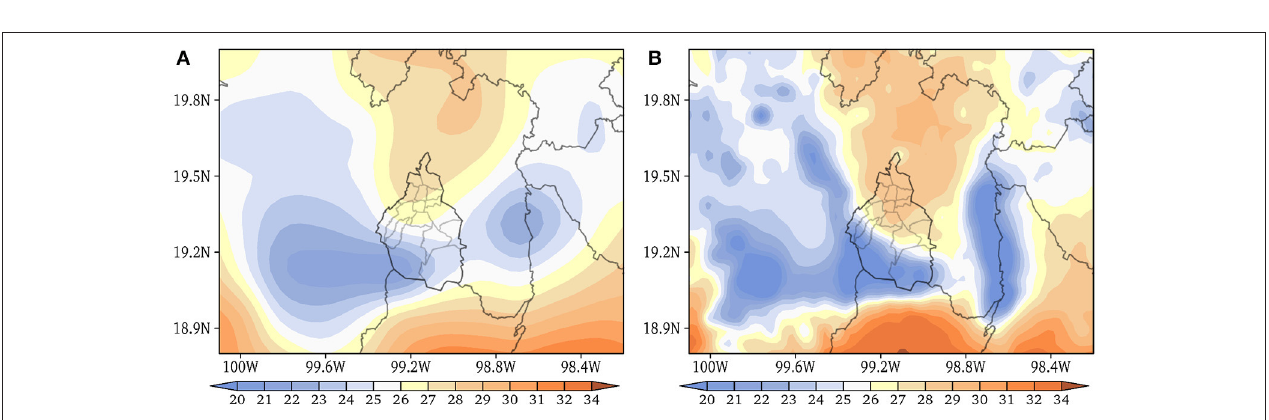
FIGURE 2 | The 2m temperature field ( ◦ C), Mexico City, from NARR (A) , and calculated orographic adjustment (B)